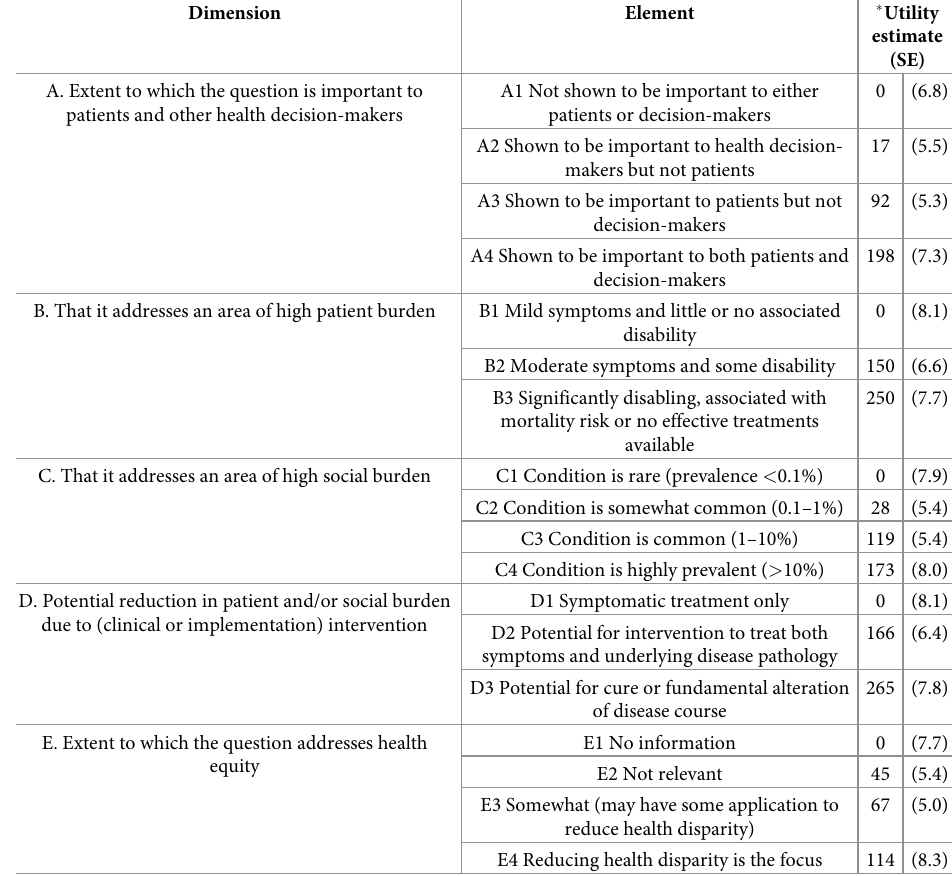
Table 4. Research Question Importance Tool (RQIT-ANZMUSC) utility values from the modified best-worst scaling survey. Dimension